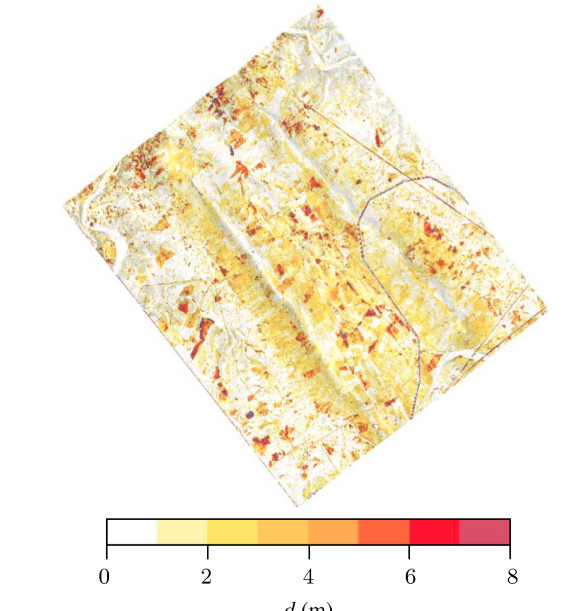
Figure 5. Minimum Euclidean distance, d , from the trees/vegeta- tion to the bare ground effectively showing their height. Results obtained from analyzing a LiDAR point cloud acquired from the database of the Perdigão Field Experiment website https://perdigao. fe.up.pt/ (last access: 10 January